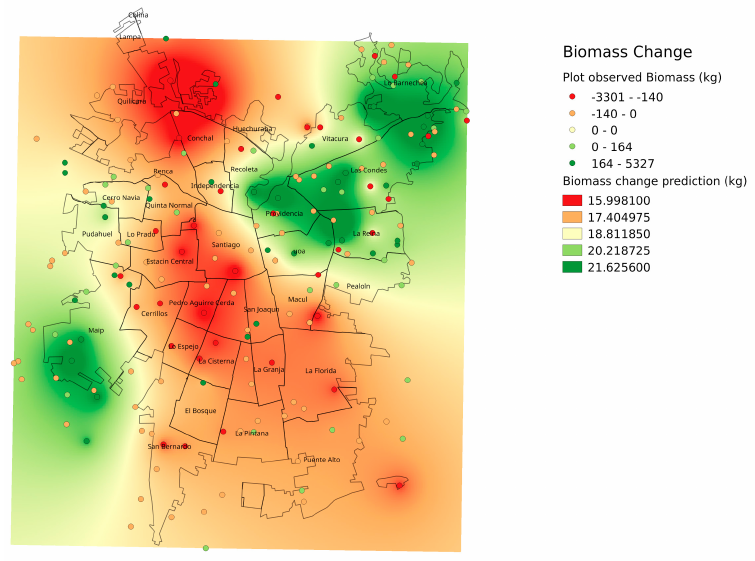
Figure 4. Urban tree biomass change prediction map for Santiago, Chile using Inverse Distance Weighting interpolation using the 192 re-measured plots.